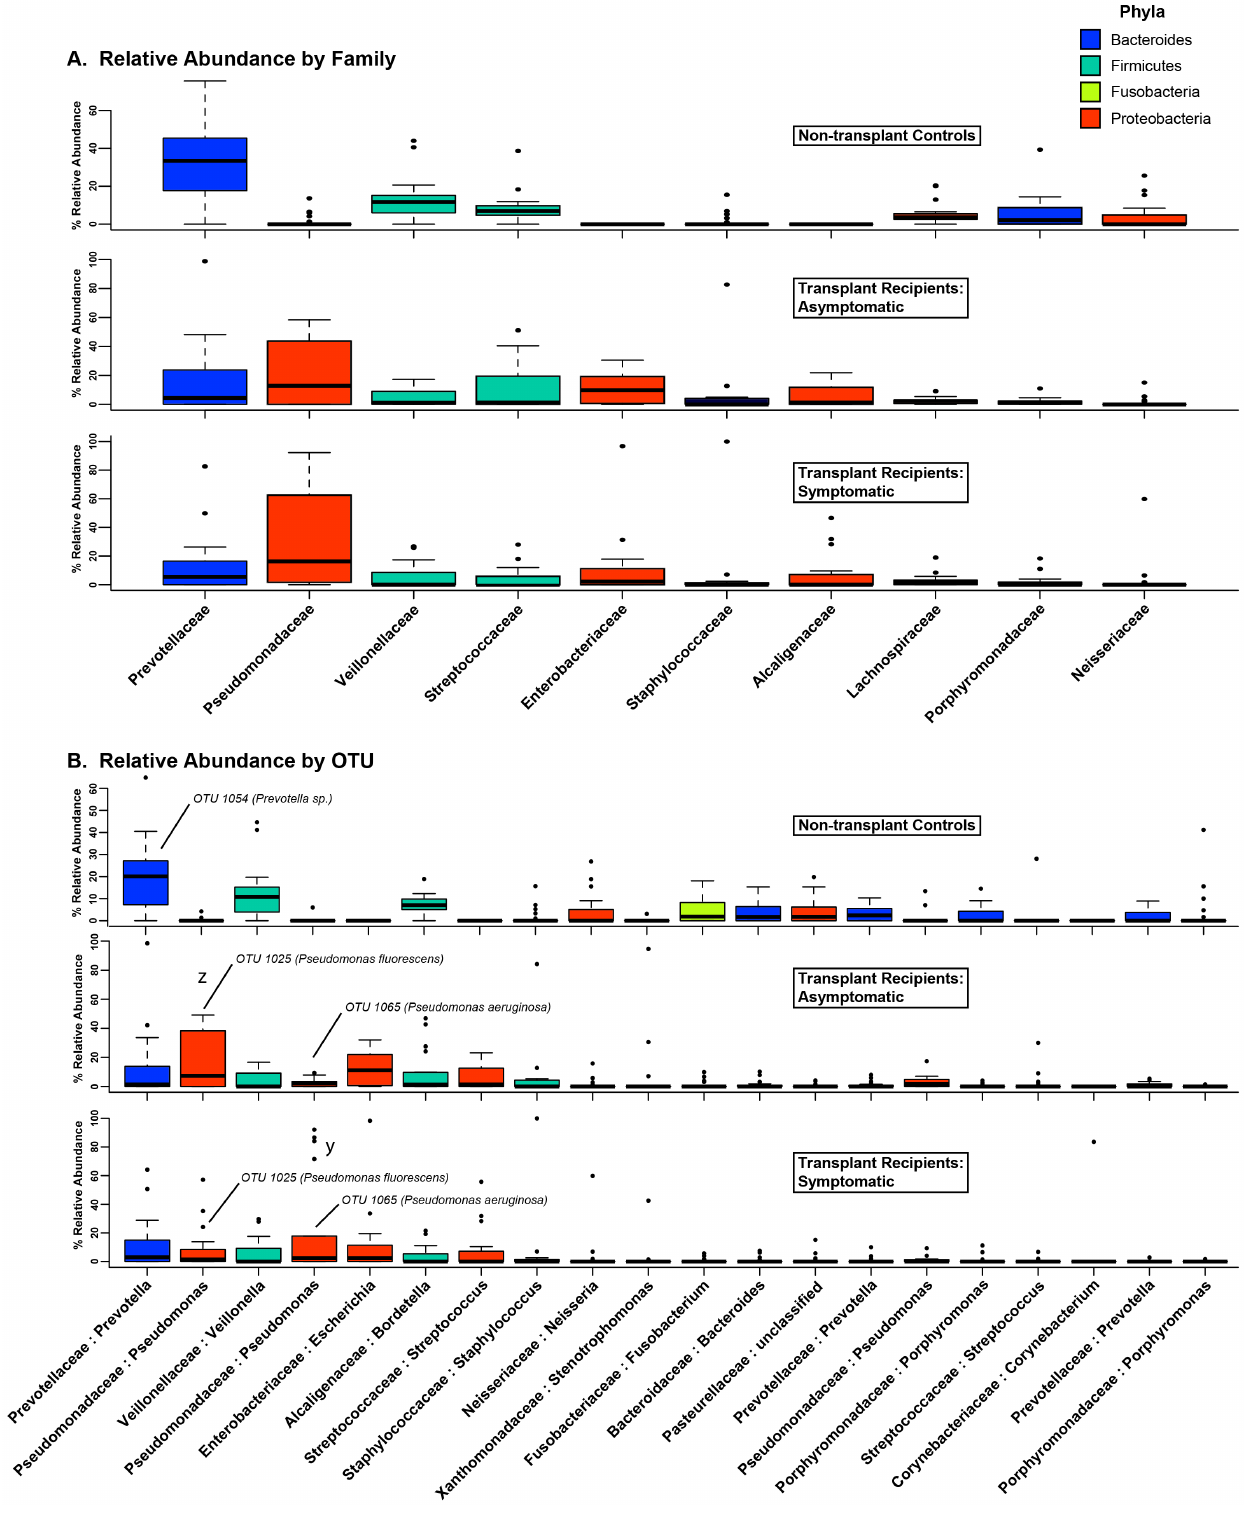
Figure 5. Taxonomic classification of the bacterial OTUs detected in BAL samples. Families and OTUs are ranked in descending order of mean relative abundance among all subjects. Box plots are colored according to phylum (see Phyla legend). Outliers are plotted as circles. A: Relative abundance of the 10 most abundant bacterial families. B: Relative abundance of 20 most abundant bacterial OTUs.